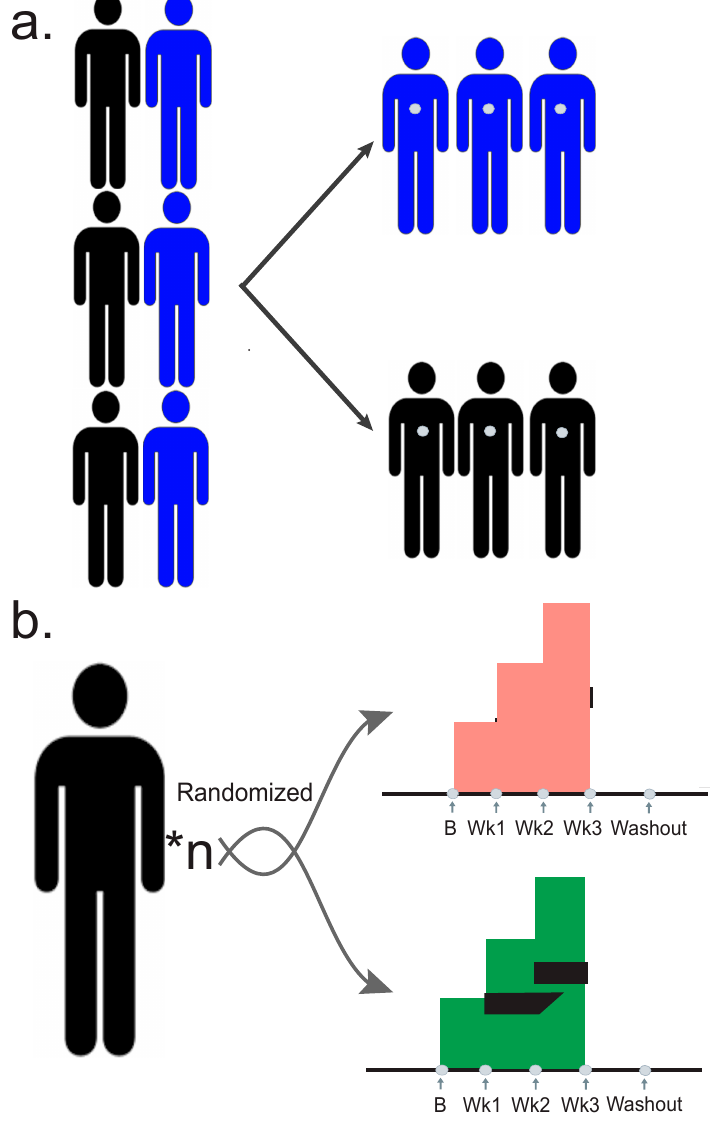
Figure 2. Typical multiomic study designs. Gray dots represent samples taken. ( a ) A case control observational study. A population is taken with participants that have the phenotype of interest (cases) and those without (controls). Cases and controls are sampled in even amounts. ( b ) A randomized longitudinal study where n participants are randomized into two arms of a study. In this case an increasing treatment dose is administered, and samples are taken every week.